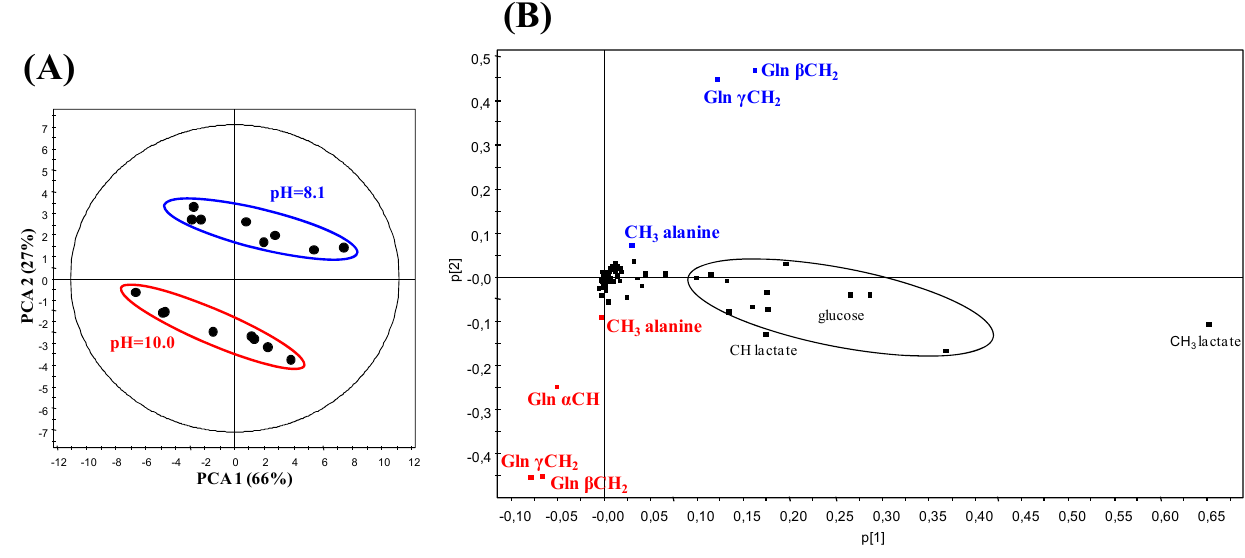
Figure 5. Score plot ( A ) and loading plot ( B ) of a Principal Component Analysis (PCA) applied to 1 H NMR spectra of eight CSF samples from AD patients recorded successively at pH 8.1 ± 0.1 and 10.0 ± 0.1. The principal discriminating metabolites are written in blue for pH 8.1 and red for pH